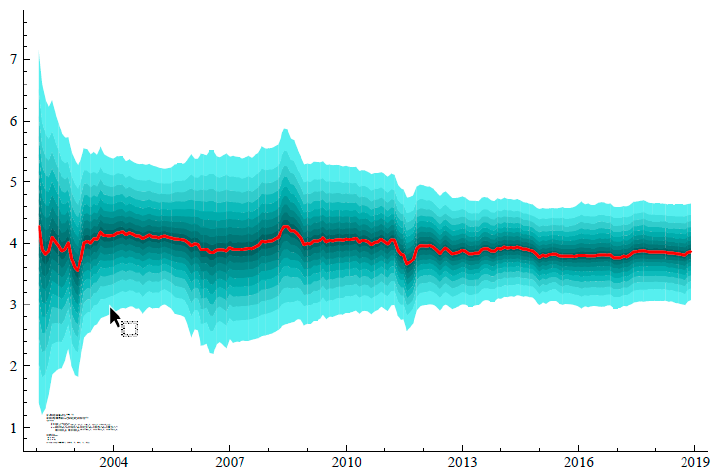
Figure 6. Recursive Estimate of Coefficient for the Broad Real Effective Exchange Rate. Bands represent twice the standard deviation of the estimate.